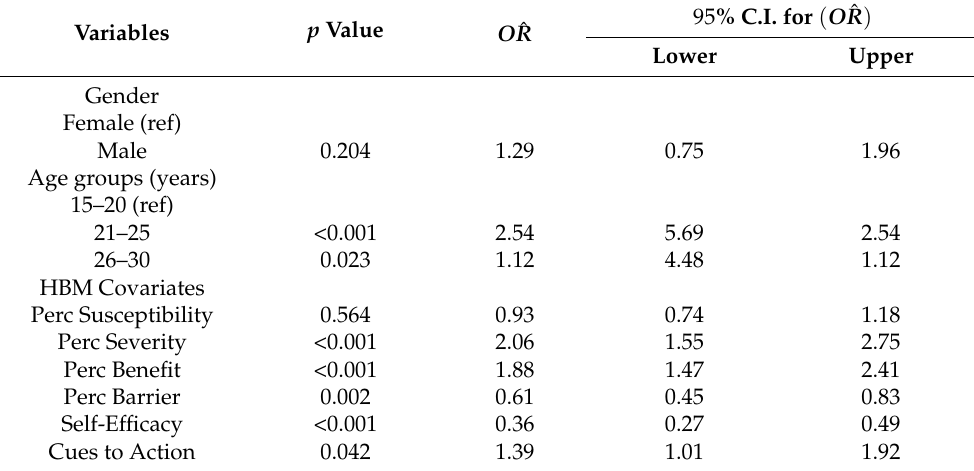
Table 3. Multivariate logistic regression analysis of independent predictors of the acceptance of COVID-19